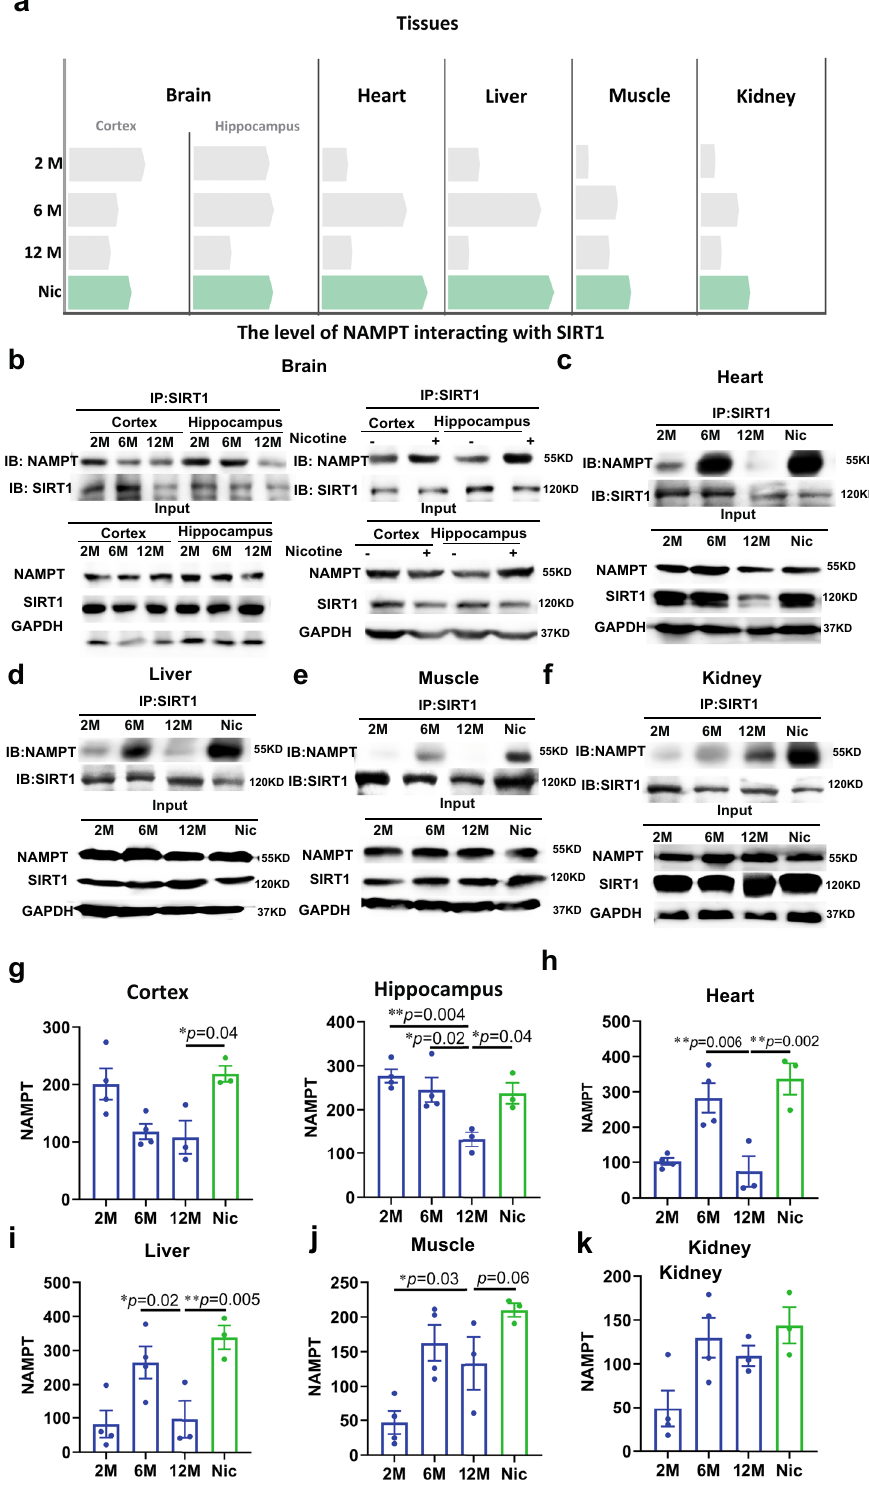
Fig.3|NicotinepromotedSIRT1bindingwithNAMPTinagedmice.a Schematic diagram of the levels of NAMPT interaction with SIRT1 in various tissues (the bars representthemeanvalueofNAMPT-SIRT1bindinglevels).ThebindingofSIRT1and NAMPTindifferent tissues: b Cortexand Hippocampus, c Heart, d Liver, e Muscle, f Kidney. Statistical diagram of NAMPT acetylation levels of different tissues: g is a